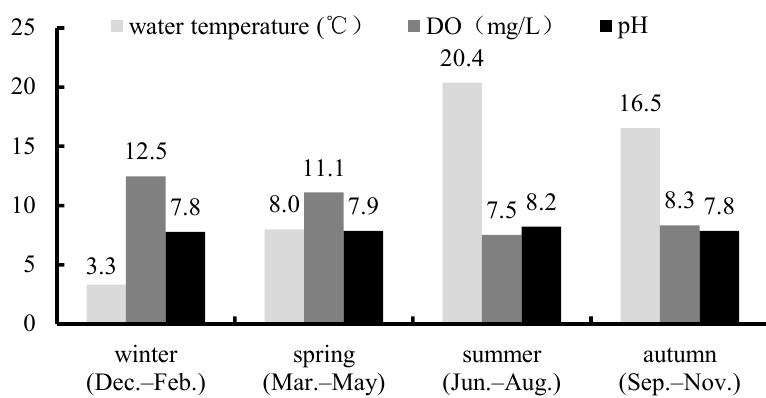
Figure 7. The seasonal variations of influenced factors in Biliuhe reservoir.